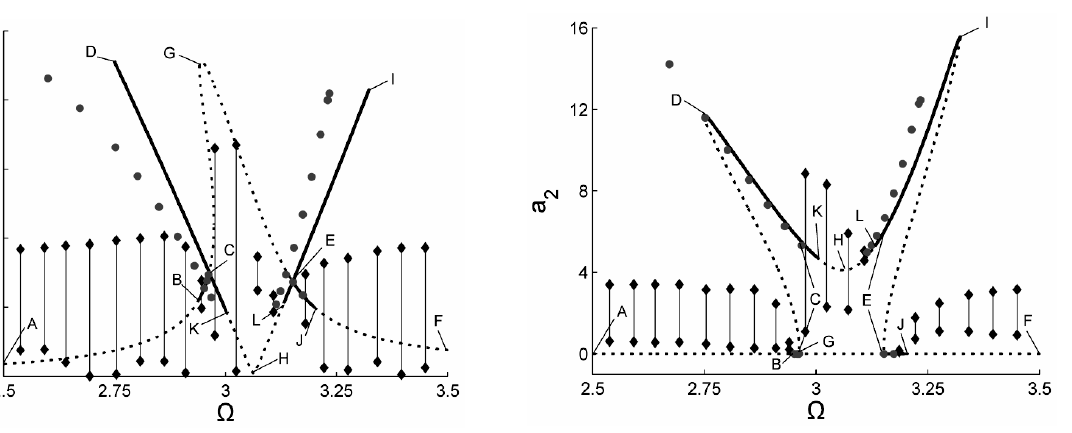
Fig. 5. Analytical and numerical results for the system with control. Analytical solution: solid line – stable solution, dotted line – unsta- ble solution. Numerical results: circle markers – amplitude of periodic motion, diamond markers – maximum and minimum amplitude of positive part of envelope of quasi-periodic motion; x 0 = 0.01, α 2 = 0.00306.